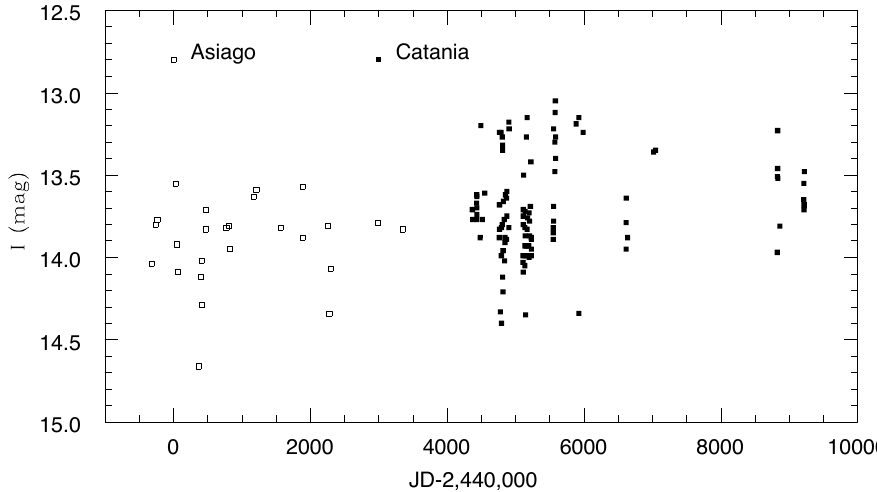
Fig. 1. Light curve in the photographic I band of V2282 Sgr from the Asiago (open squares) and Catania (filled squares) archives. Due to its southern position in the sky, the coverage shows a marked seasonal